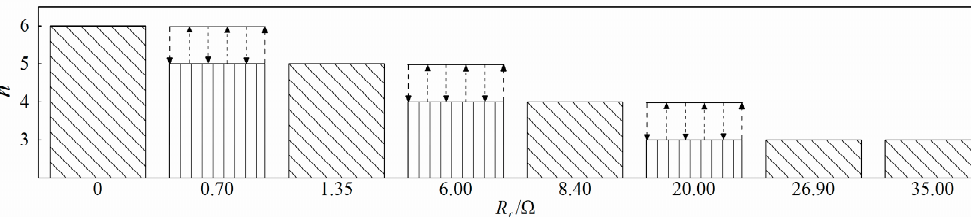
Figure 6. Relationship between fault resistance and NOCD (number of conducting diodes).